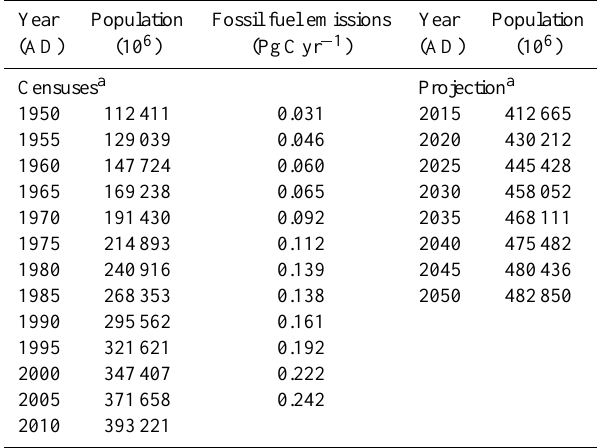
Table 3. Population growth and fossil fuel emissions, South Amer-